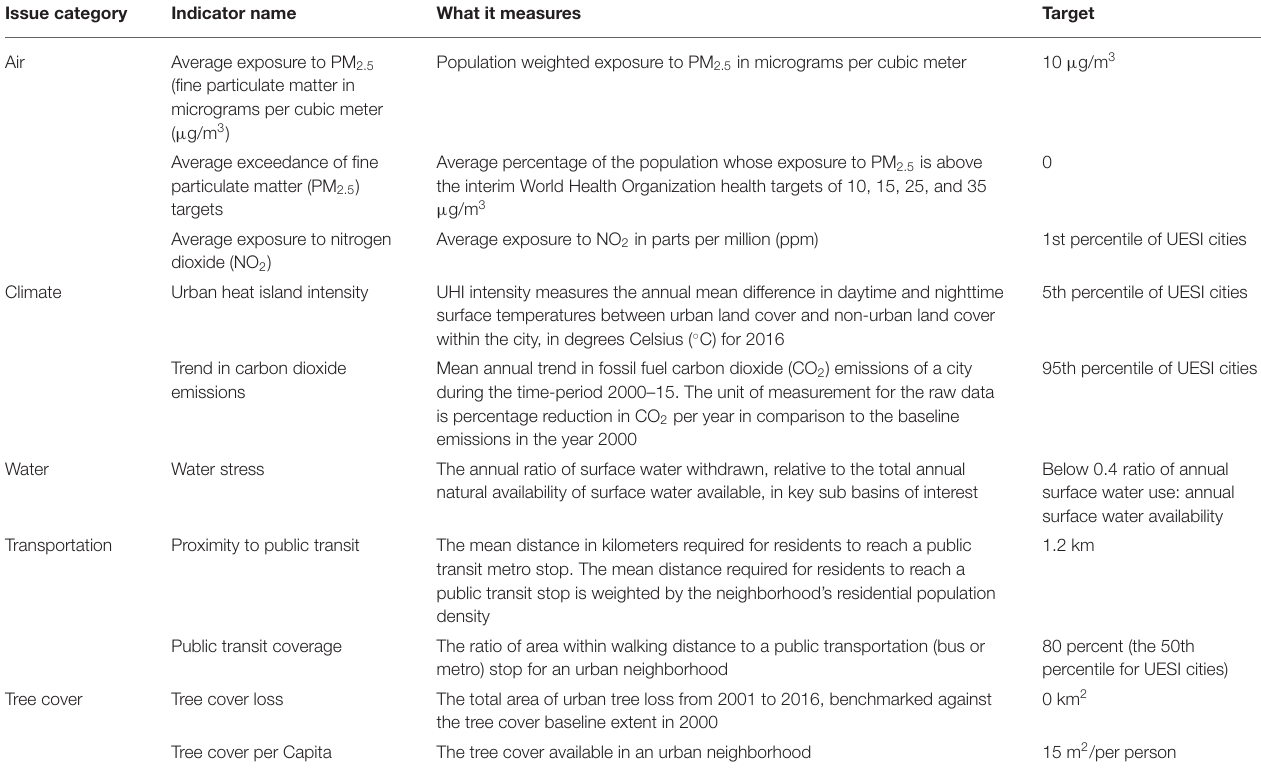
TABLE 2 | Summary of UESI environmental indicators, definitions, and